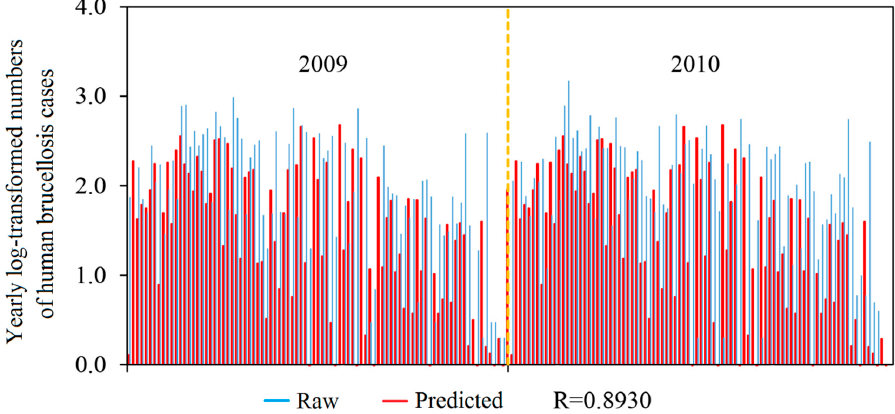
Figure 5. Comparison between predicted (red) and raw yearly log-transformed numbers of human brucellosis cases (blue) at the county level in the model assessment phase. X -axis denotes counties, with 89 counties listed horizontally in the same order in both panels (2009 and 2010).